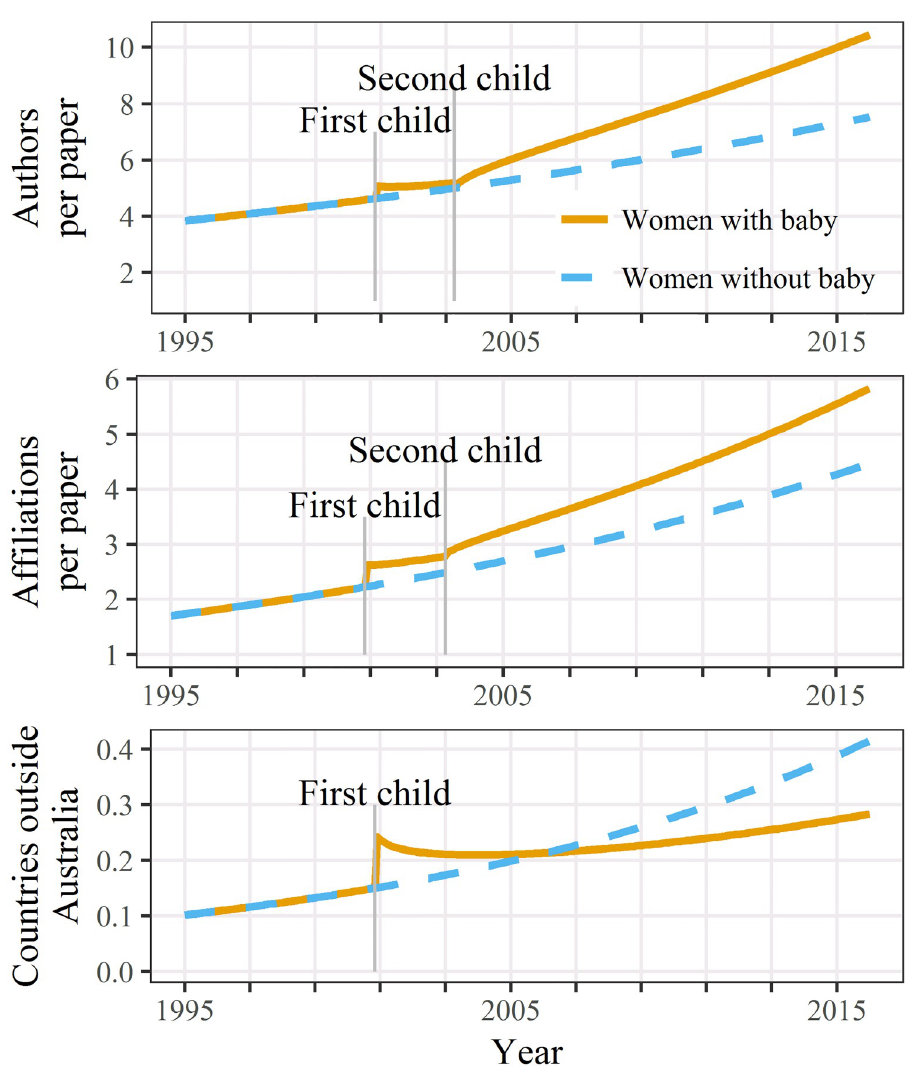
Fig 5. Estimated number of authors, affiliations, and co-author countries outside Australia per paper over time for women caring for two children and women caring for none after leaving out two statistically influential women. Estimates shown for a career beginning in 1995. Compare with Fig